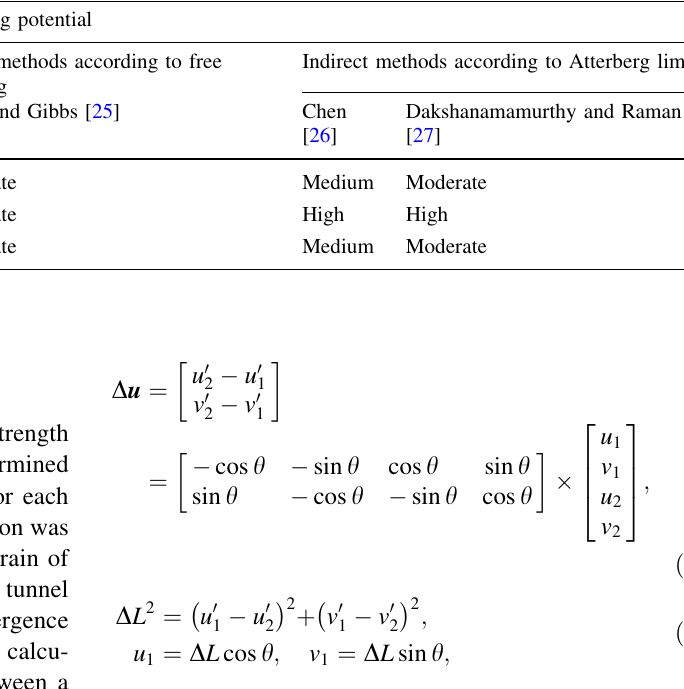
Indirect methods according to Atterberg limits [26]